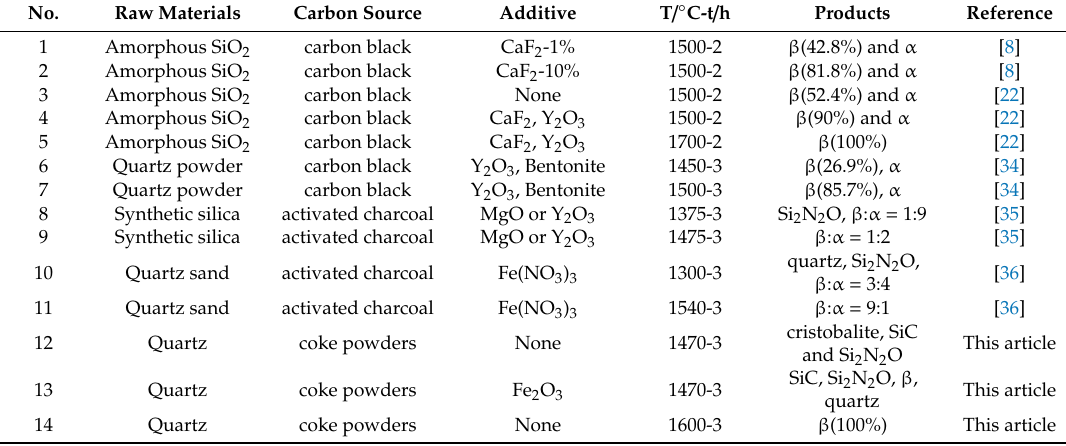
Table 4. Comparison of reaction conditions and products by carbothermal reduction nitridation of SiO 2 reported in the literature and the present